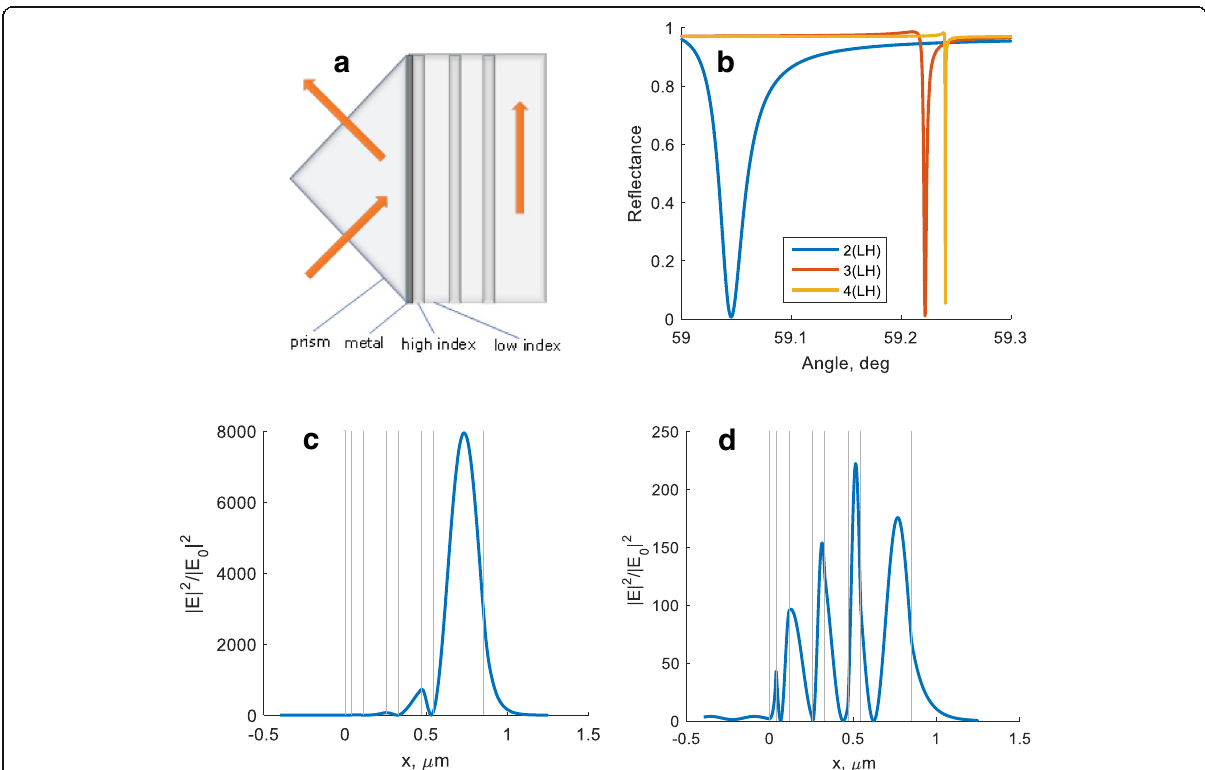
Fig. 1 MMD structure ( a ). Reflectance of MMD structure with two, three, and four pairs of HL dielectric layers ( b ). Distribution of light intensity inside MMD structure at 532-nm wavelength under resonance conditions for TE waveguide mode ( c ) and TM hybrid plasmonic mode ( d ). Vertical gray lines represent MMD structure